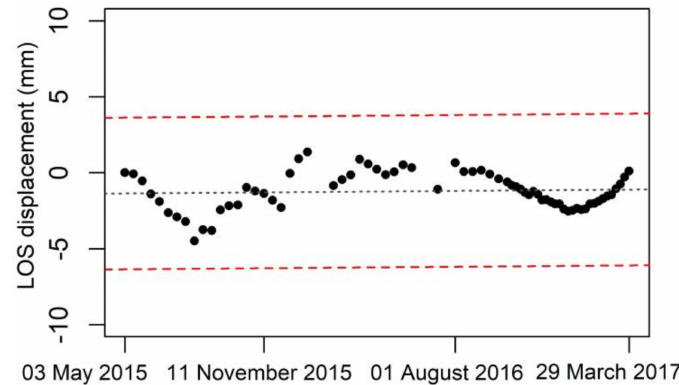
Figure 4. Average displacement time series (TS) of the targets characterized by coherence higher than 0.9 and LOS velocity in the range ± 0.5 mm/year. The black dotted line represents the regression line of the average TS whereas the red ones are the upper and lower threshold